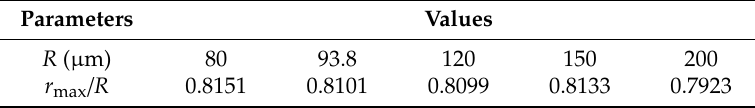
Table 5. The relative distance of the maximum amplitude for di ff erent radii R . Parameters